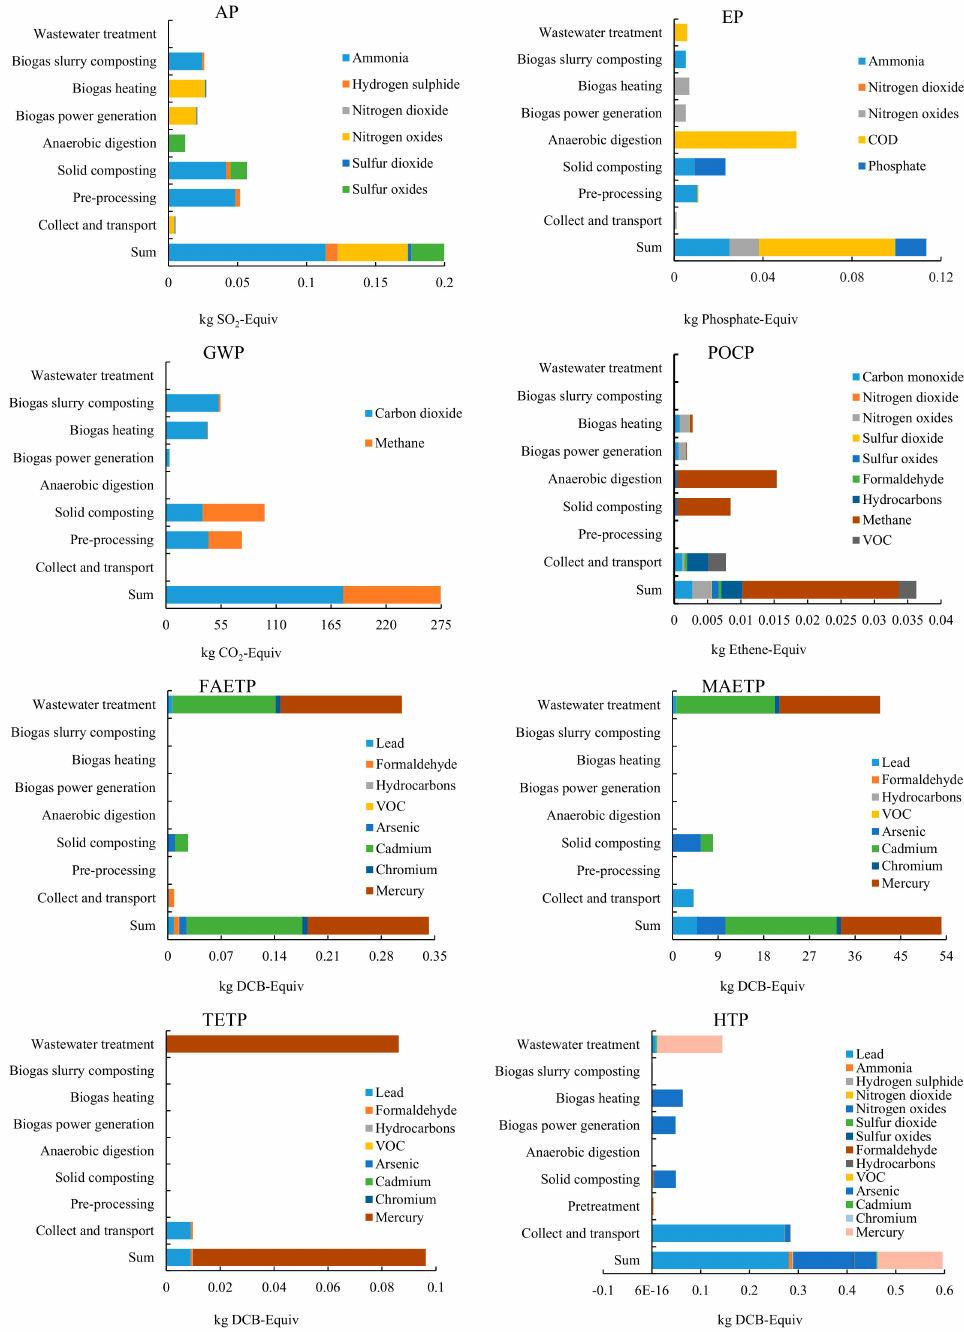
Figure 3. Main factors influencing di ff erent types of environmental